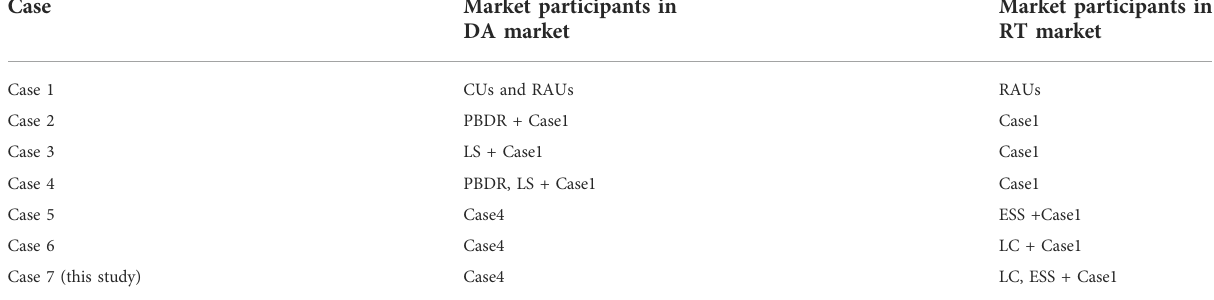
TABLE 6 Different cases of market participants.